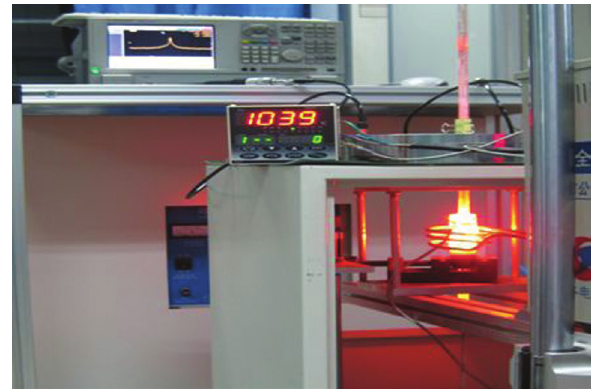
Figure 1: Dielectric constant measurement